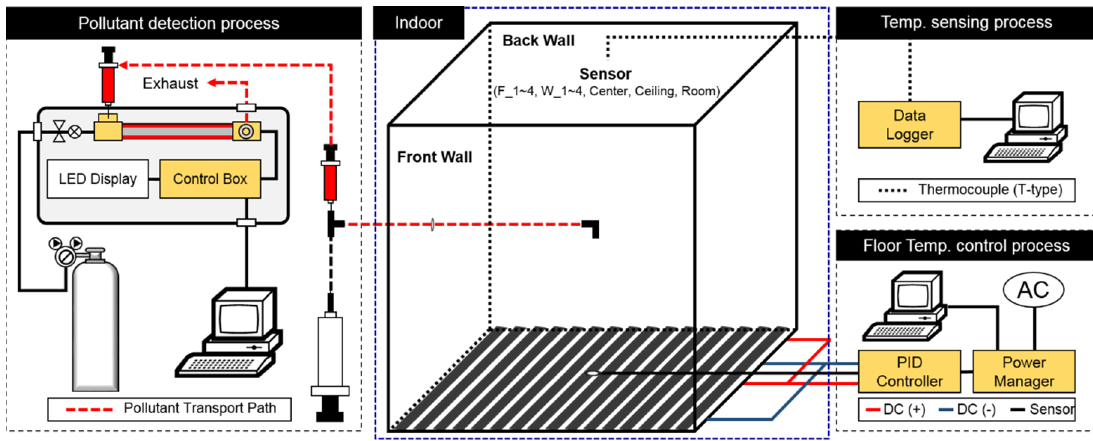
Figure 1. Diagram of the Experiment.